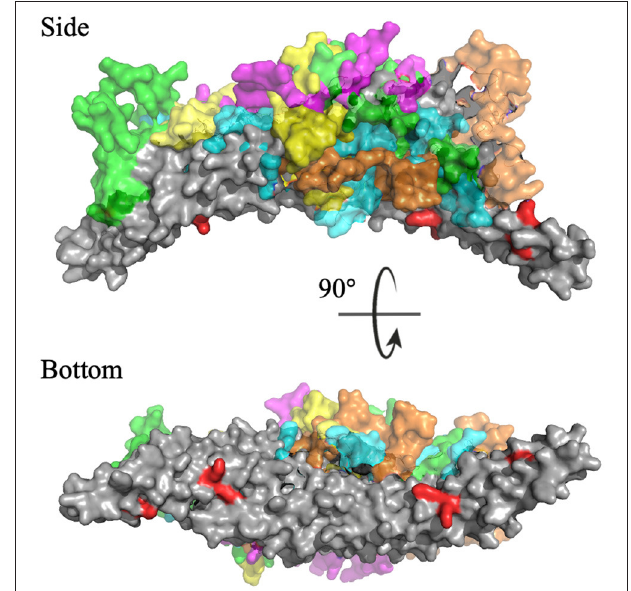
FIGURE 11 | Cluster analysis reveals the most probable positions of the C-termini. The dimeric BAR domain is shown in gray and each cluster of the C-termini is shown in a unique color. Cluster 1 (purple) represents 66.6% of the frames, Cluster 2 (green) represents 38.9% of the frames, Cluster 3 (cyan) represents 22.3% of the frames, Cluster 4 (orange) represent 7.5% of the frames, and Cluster 5 (yellow) represents 4.6% of the frames. K251, K252, K257, K266, and K268 are colored